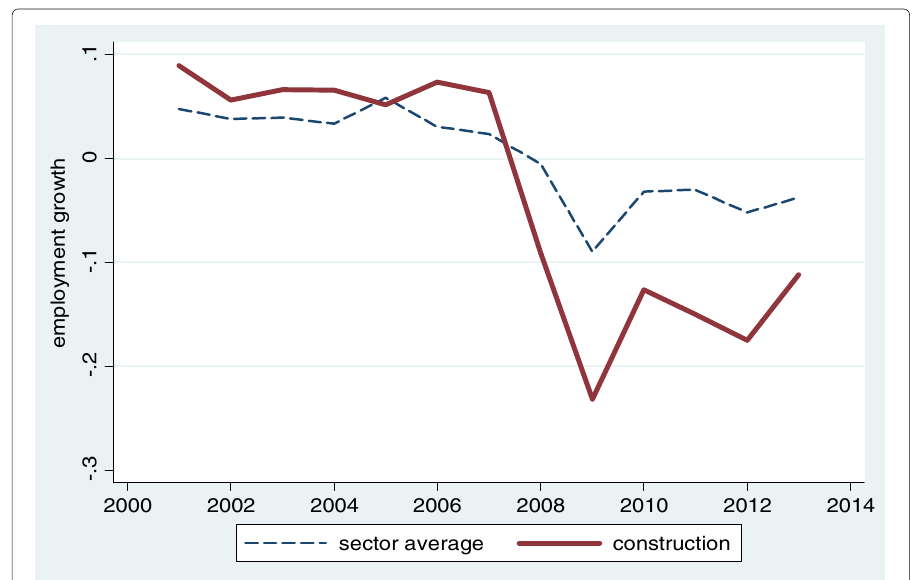
Fig. 5 Employment growth in Spain. Source: Spanish Labor Force Survey